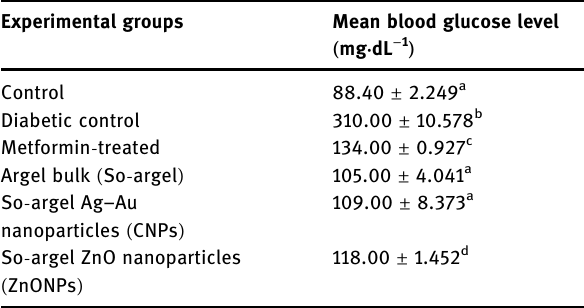
Table 1: Blood glucose levels ( mean ± SE ) of rats in the experi - mental groups